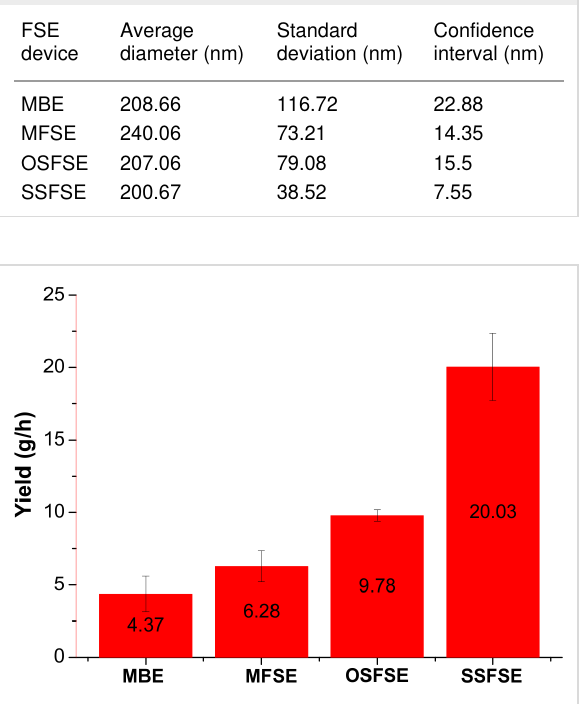
Table 4: Average diameter of the nanofibers produced by the four dif- ferent FSE devices.